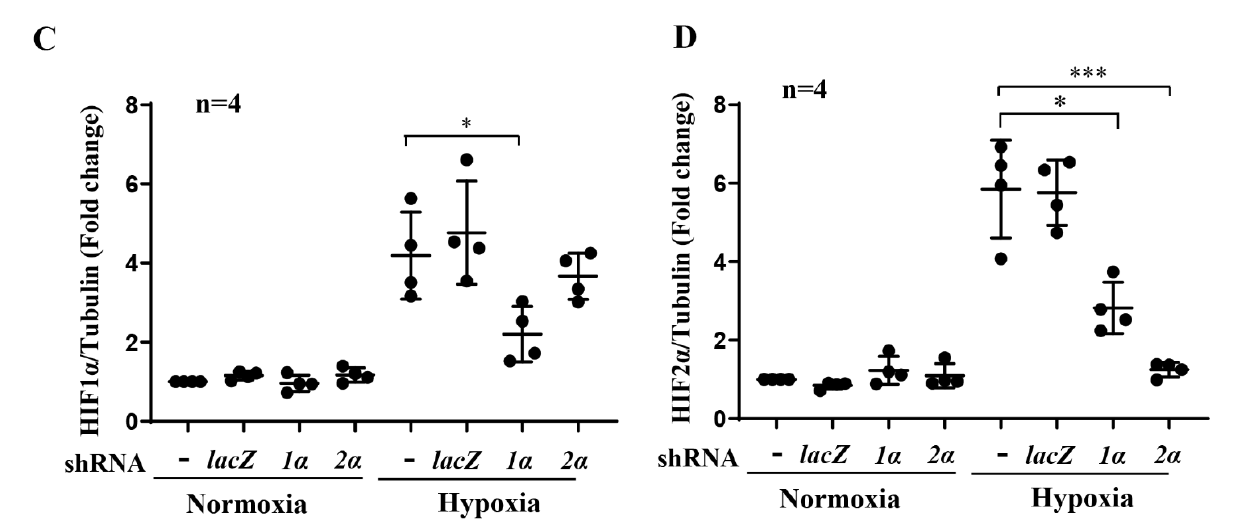
Figure 2. Role of HIFs in Arg-II upregulation by hypoxia in human podocytes. ( A ) Representative immunoblotting results of the protein levels of Arg-II, HIF1 α , and HIF2 α in different groups of podocytes. Tubulin serves as the loading control. ( B – D ) Quantification of the signals of Arg-II, HIF1 α , and HIF2 α , respectively. Lanes 1 and 5: wild-type podocytes AB8/13; Lanes 2 and 6: podocytes transduced with control rAd/U6- lacZ shRNA ; Lanes 3 and 7: podocytes transduced with rAd/U6- hif1 α shRNA ( 1 α ); Lanes 4 and 8: podocytes transduced with rAd/U6- hif2 α shRNA ( 2 α ). * p < 0.05, *** p < 0.001 between the indicated groups. n = 4.